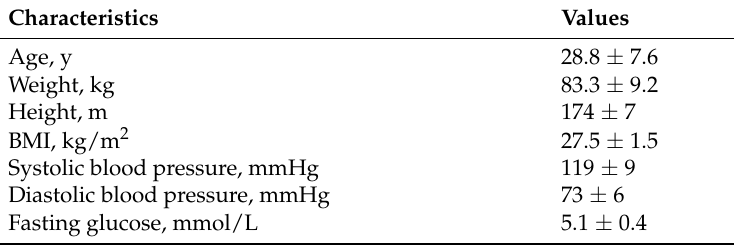
Table 3. Baseline characteristics of the 25 overweight men and women 1